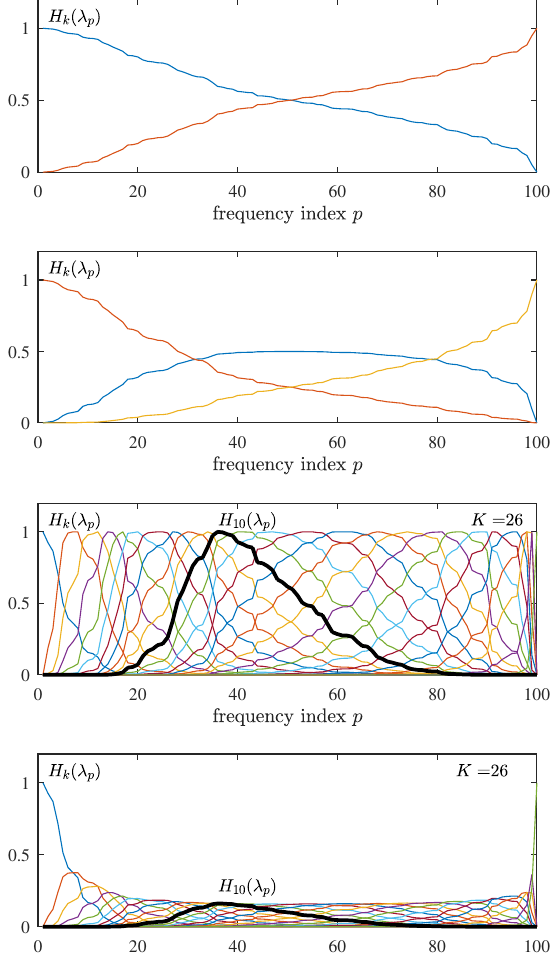
Figure 6. The spectral domain transfer functions H k ( λ p ) , for a general graph p = 1,2, . . . , N , k = 0,1, . . . , K − 1, that correspond to the terms of the binomial form for K = 26. Example 4. Vertex-domain implementation is based on the multiplication of signal, x , by the graph Laplacian L . For each vertex n it is localized to its neighborhood one. After the signal Lx is calculated, then the new signal L 2 x is easily obtained as the graph Laplacian multiplication with (cid:16) (cid:17) the calculated signal, Lx , that is L 2 x = L . This procedure is continued up to the any order, Lx (cid:16) (cid:17) L k x = L L k − 1 x